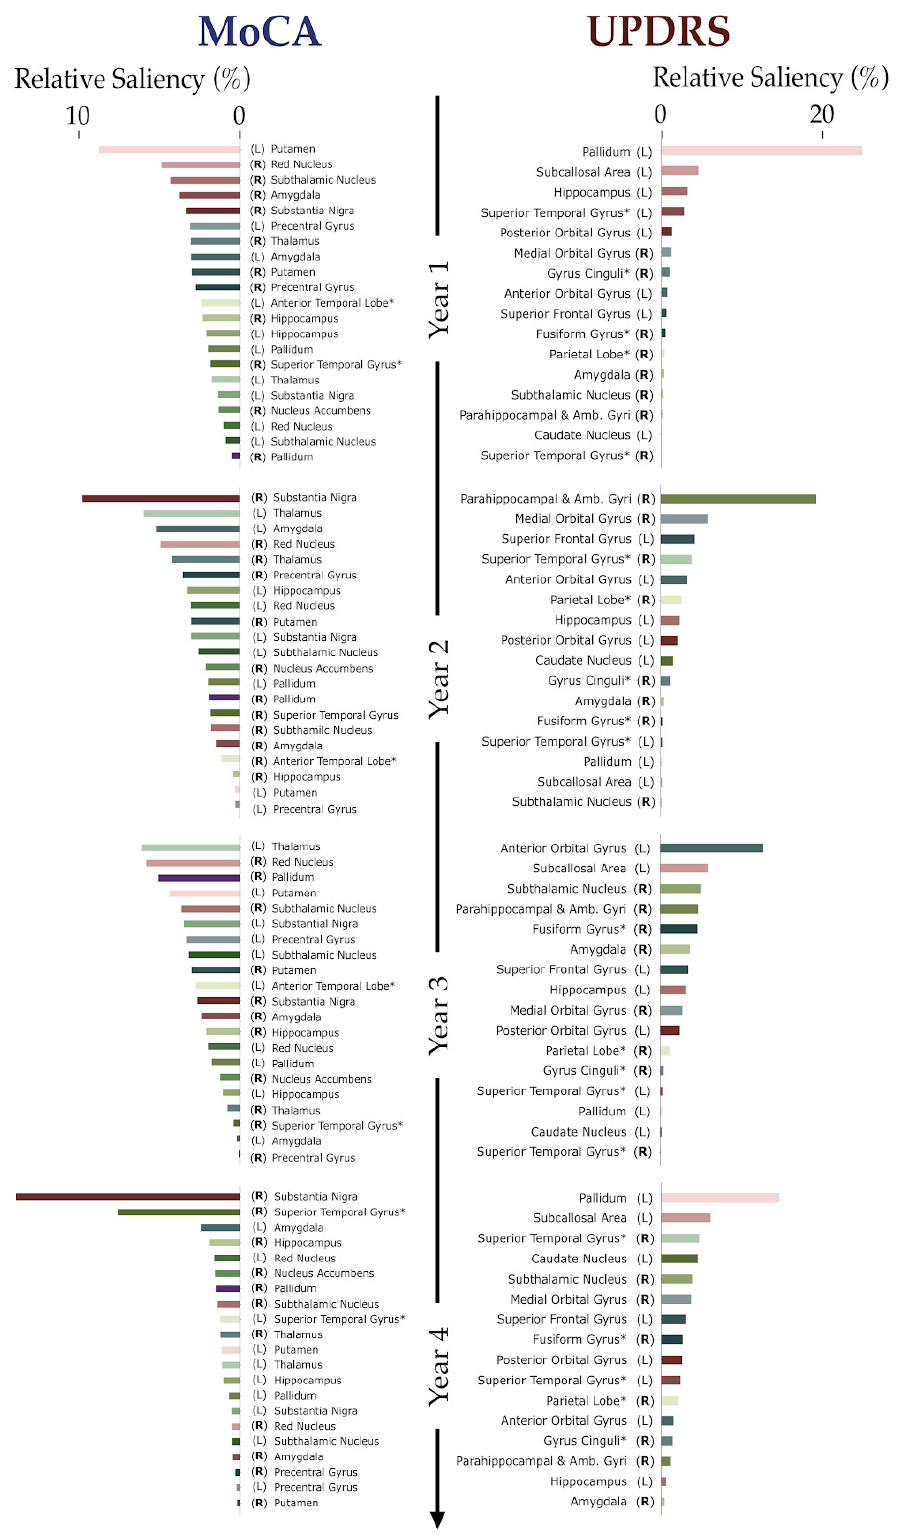
Figure 3. Relative saliency of di ff erent regions over time. From top to bottom, percentual value of saliency for each neural network predicting MoCA (left) and UPDRS (right) for all 4 years 1–4. Colors follow each region and show the reordering of principal salient regions responsible for the score predictions. Right hemisphere regions are emphasized to show that similar reordering also happens in the level of the whole brain. See SI for full names of abbreviated